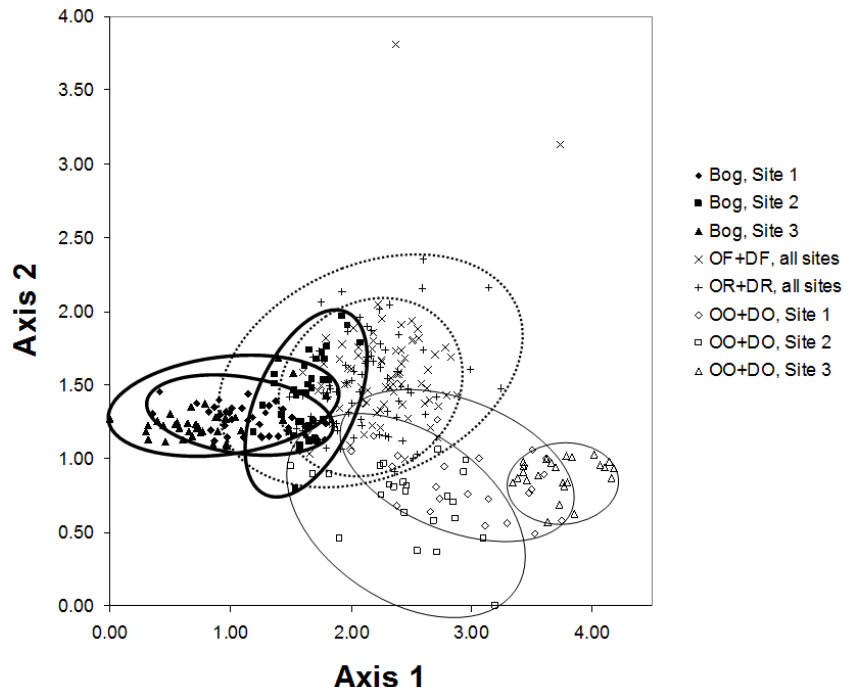
Figure 6. Vegetation groupings in a correspondence analysis ordination of individual quadrats based on cover of the species present ten years after restoration. Each ellipse includes all the quadrats of the grouping it represents, except the ellipse representing the OF and DF treatments, from which two extreme outliers have been omitted. Ellipse boundaries: bold = existing bog sites, dotted = felled/removed sites, weak solid line = control & blocked sites with trees left